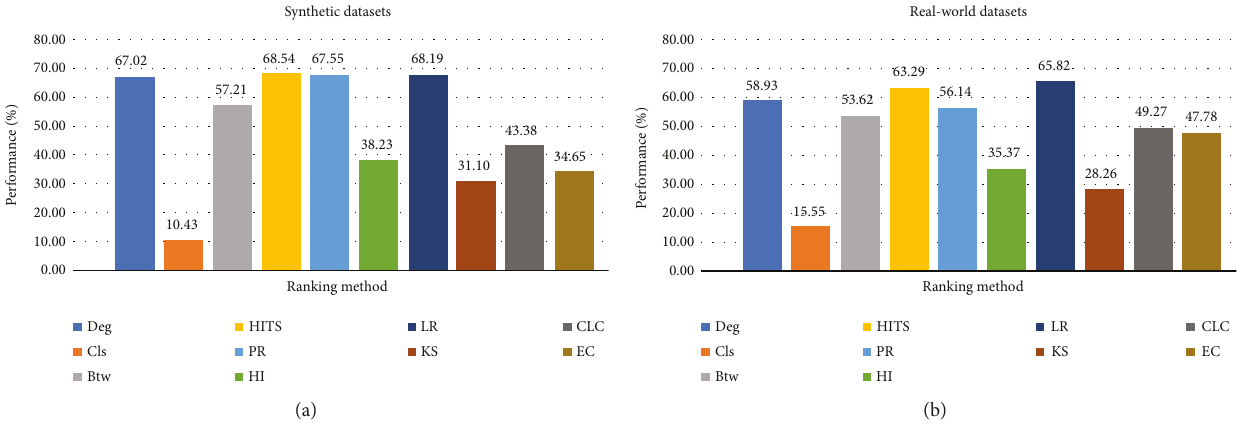
Figure 4: Coverage performance (0 – 100%) of each ranking method cumulated over all synthetic, respectively, all real-world datasets.